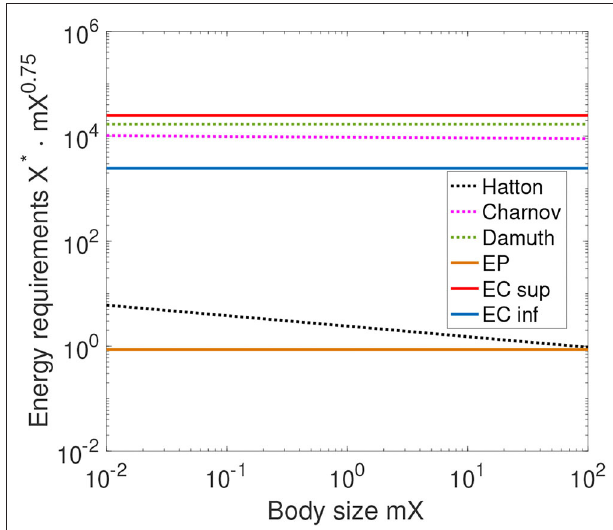
FIGURE 4 | Energy requirements. The green dotted color represents Damuth’s rule, the black dotted color represents the adjustment for a large group of species made by Hatton et al. (2019) and the purple dotted represents (Charnov et al., 2001). The solid lines orange, red and blue energy requiriments of apex predator and the upper and lower bounds for consumer. The parameter values used are: α = 3 / 4, β = 1 / 2, K 0 = 5, δ C = 0.74, = 0.3, m R = 1, m C = 2, m P = 8, ρ = 1.1, and ρ = 10 3.7 . Note e C = 10, f R CR C that the equilibrium abundance of the consumer is between the upper and lower bounds as well as that of the apex